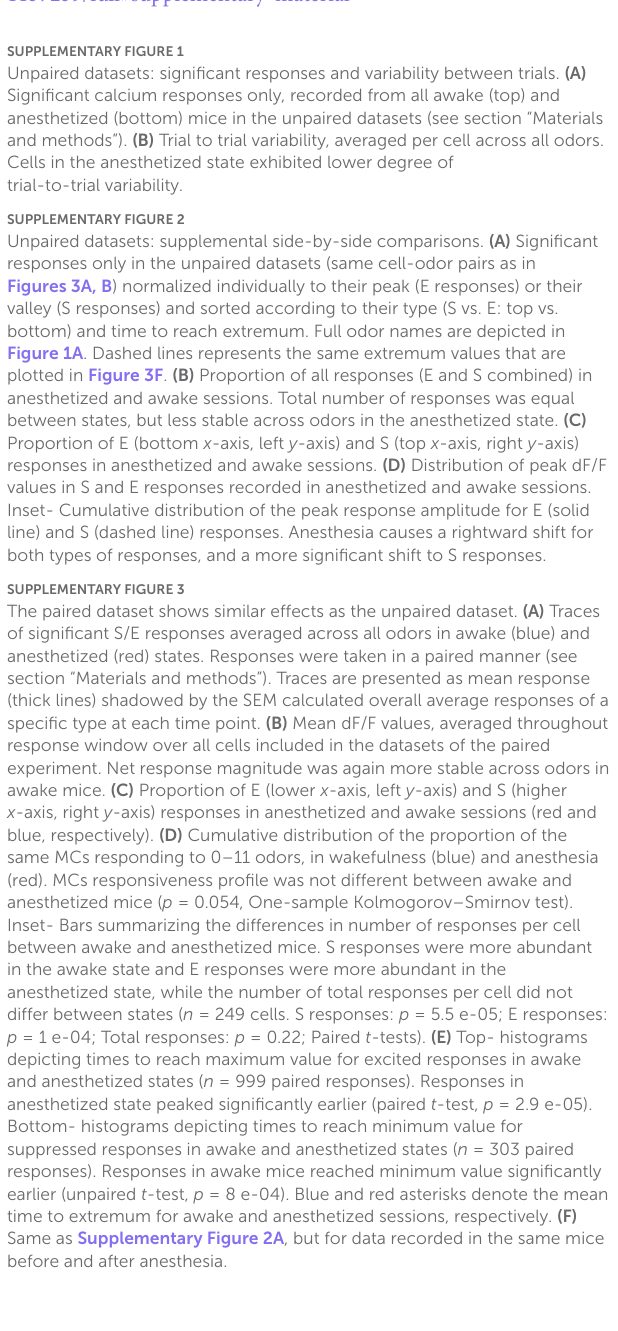
SUPPLEMENTARYFIGURE1 Unpaired datasets: significant responses and variability between trials. (A) Significant calcium responses only, recorded from all awake (top) and